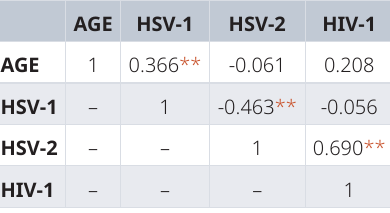
Table 3. Correlation between age, HIV-1 ELISA positive samples, HSV-1 and HSV-2 PCR positive samples.